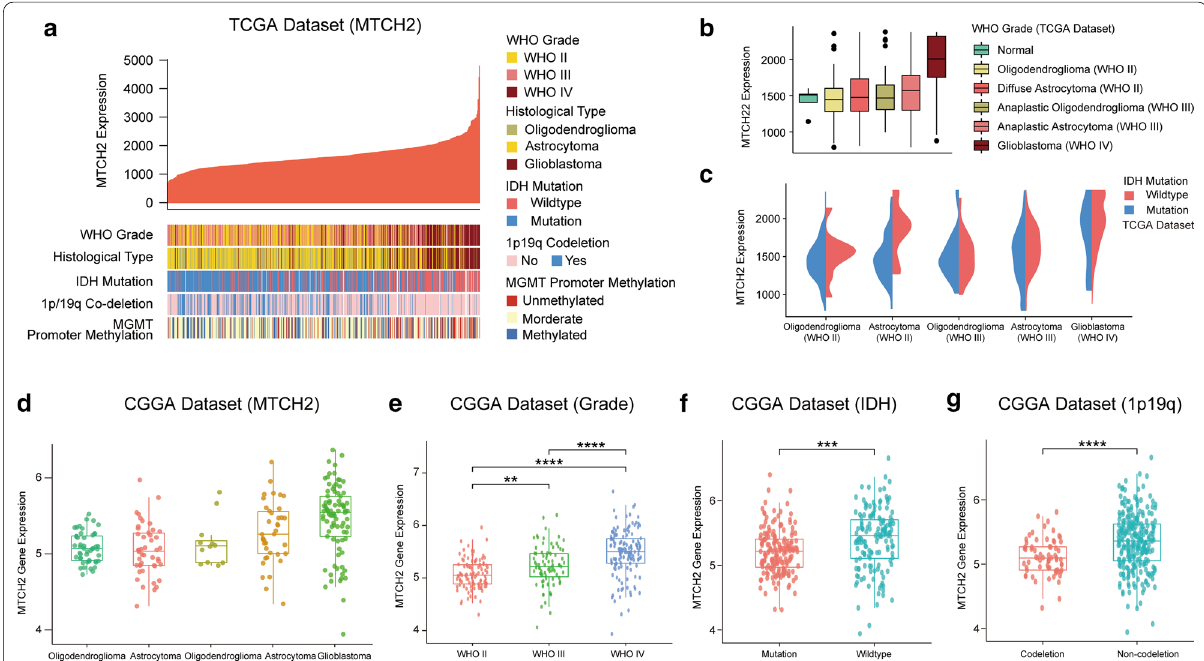
Fig. 2 MTCH2 expression is associated with glioma malignancy. a Correlation between MTCH2 expression (FPKM) and glioma histology and prognostic biomarkers in The Cancer Genome Atlas (TCGA) dataset. Patients (N 681) are sort by MTCH2 expression. Glioma histology and = biomarkers of patients are shown in color code. b Diagrams showing MTCH2 expressions in glioma histology groups. c Diagrams showing MTCH2 expression of gliomas with IDH status in the TCGA dataset. d – g Diagrams showing MTCH2 expression of gliomas with tumor grade, histology,